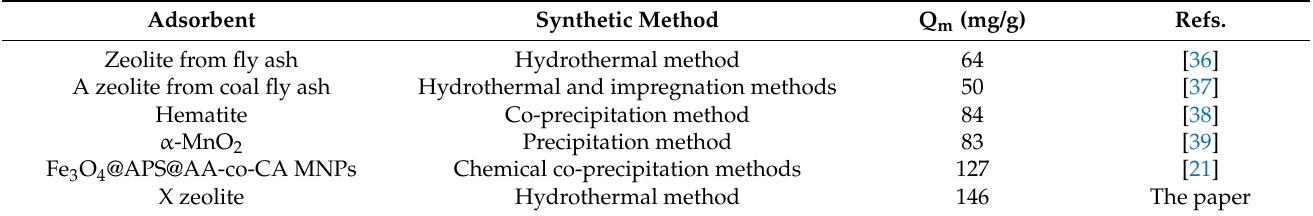
Table 6. Comparison of adsorption capacities of various adsorbents for Cu 2+ .